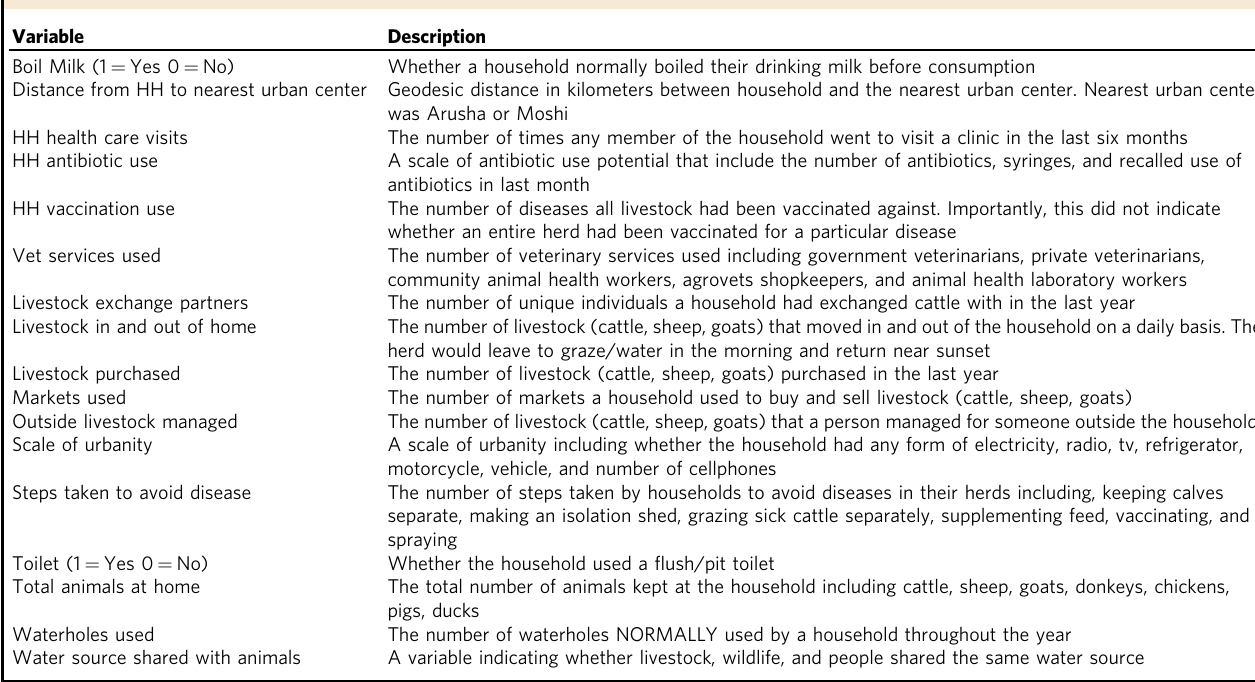
Table 5 Description of variables entered into multivariate